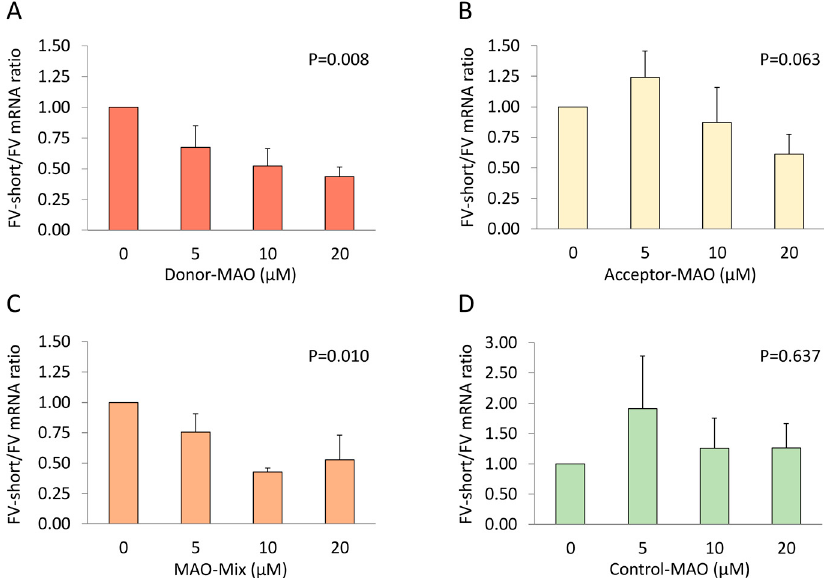
Figure 5. Quantitative analysis of full-length FV and FV-short transcripts in untreated and treated HepG2 cells. HepG2 cells were treated with 0–20 µ M morpholino antisense oligonucleotides (MAOs) for 48 h. Total RNA was isolated and reverse-transcribed into cDNA, and the full-length FV and FV-short transcripts were quantified by real-time qPCR analysis. The FV-short/full-length FV mRNA ratio, normalised to the FV-short/full-length FV ratio of untreated cells, was plotted as a function of the concentration of ( A ) a MAO targeting the FV-short-specific donor splice site (Donor-MAO), ( B ) a MAO targeting the FV-short-specific acceptor splice site (Acceptor-MAO), ( C ) a 1:1 mix of Donor-MAO and Acceptor- MAO (MAO-mix), and ( D ) a control MAO with an irrelevant sequence. Results are reported as mean ± S.E.M. of three biological replicates (two for the Control-MAO). The numbers in the top right corner of each graph represent the p-for-trend (Jonckheere-Terpstra trend test) of the respective titrations. Note the different y -axis scale for